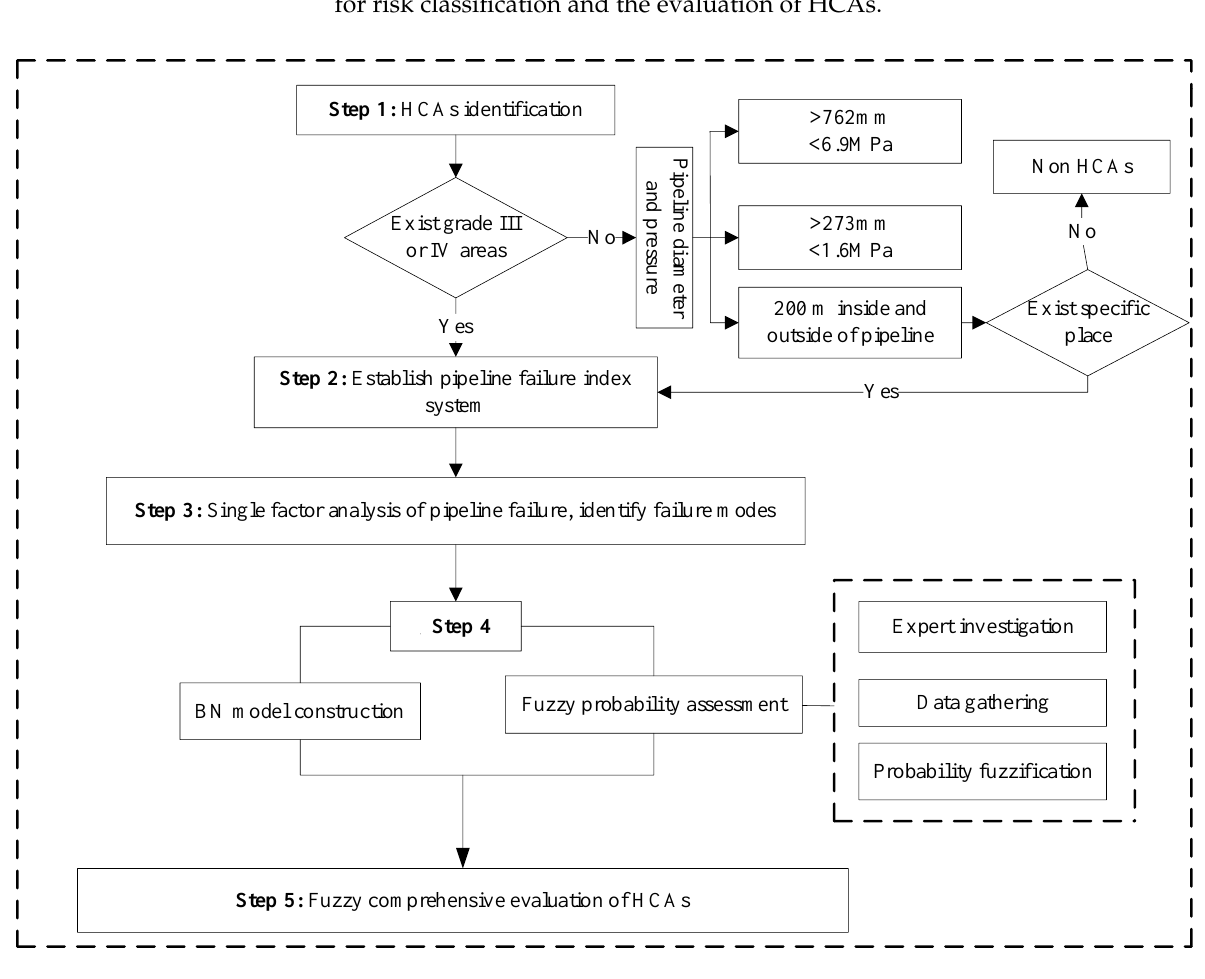
Figure 1. Hierarchical management flow chart of HCAs.